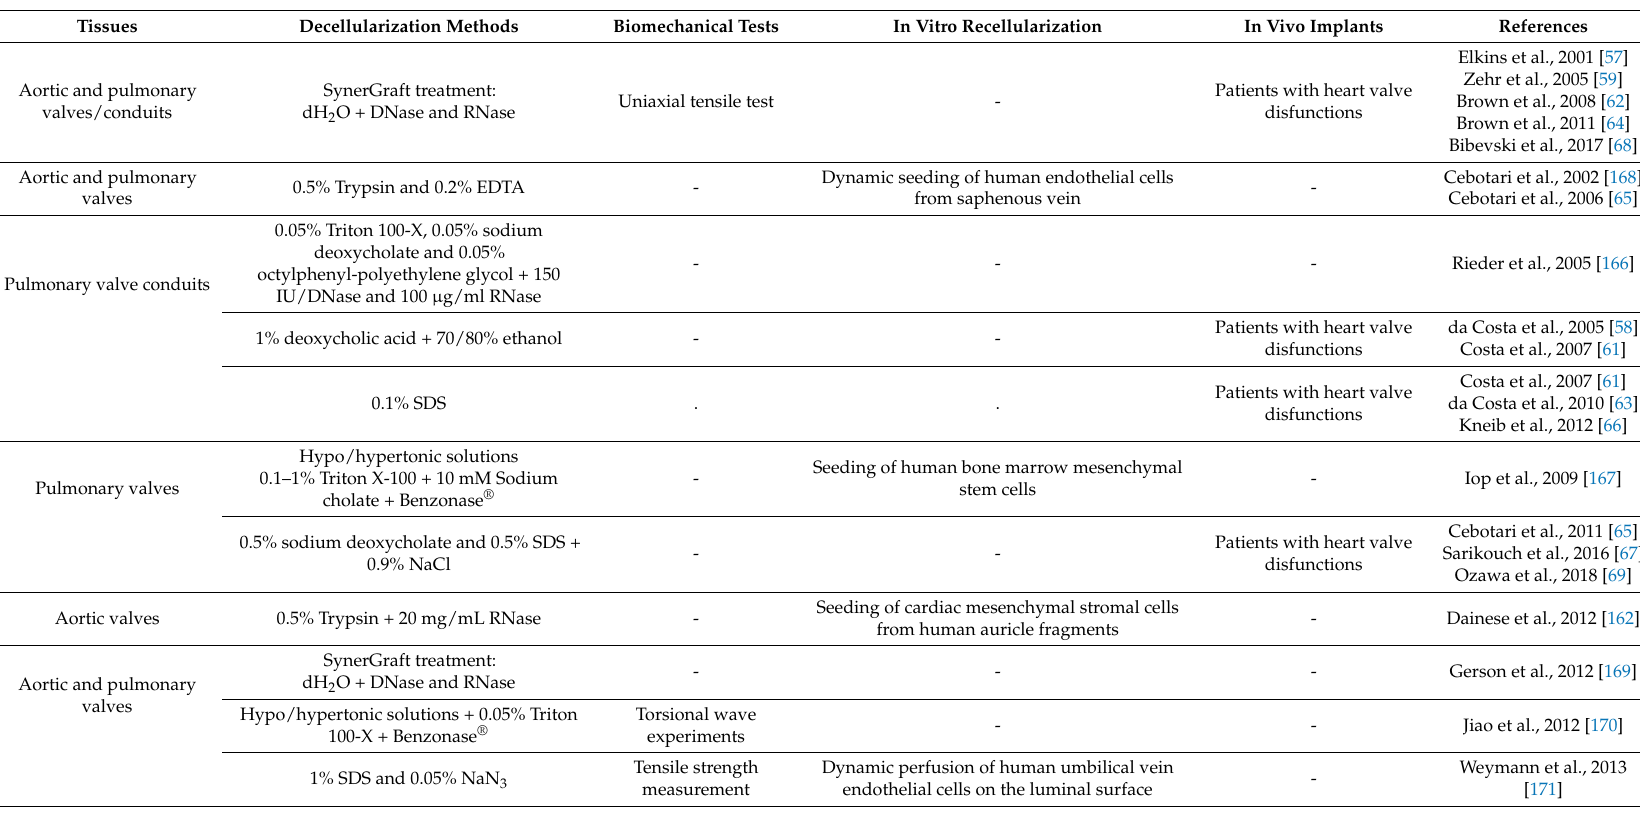
Table 5. Heart valves. Decellularization techniques, biomechanical tests, recellularization methods, and in vivo implants of human heart valve extracellular